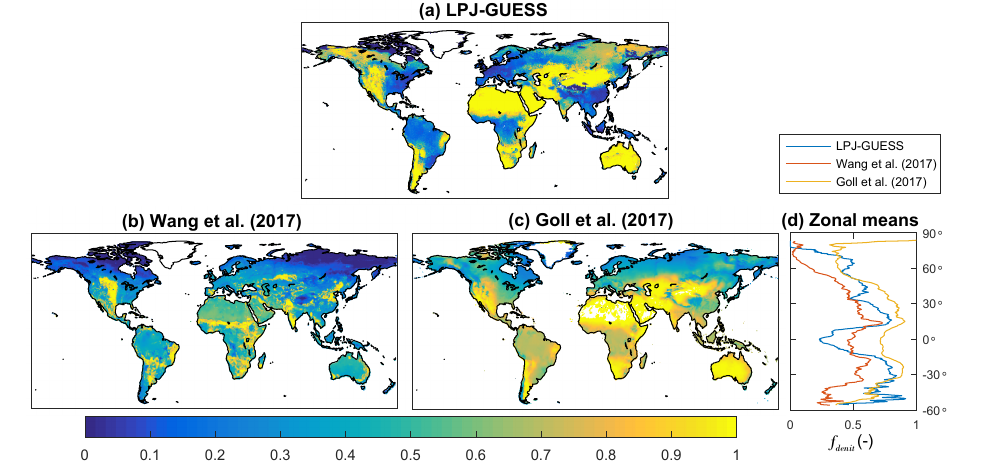
Figure 10. Relative contribution of denitrification to total soil N loss (excluding fire). (a) Prediction by LPJ-GUESS for the true historical simulation ( + Ndep + clim + CO 2 ), 1997–2006. (b) Estimate by Wang et al. (2017). (c) Estimate by Goll et al. (2017). (d) Latitudinal averages.